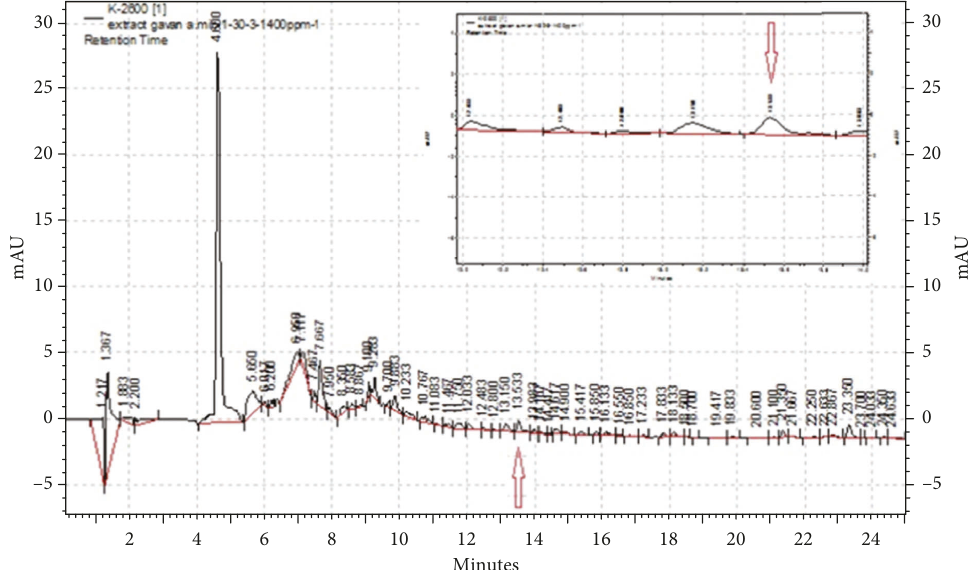
Figure 2: HPLC diagram of the extract with a concentration of 1,000ppm. The red arrow indicates the location of the genistein peak in the